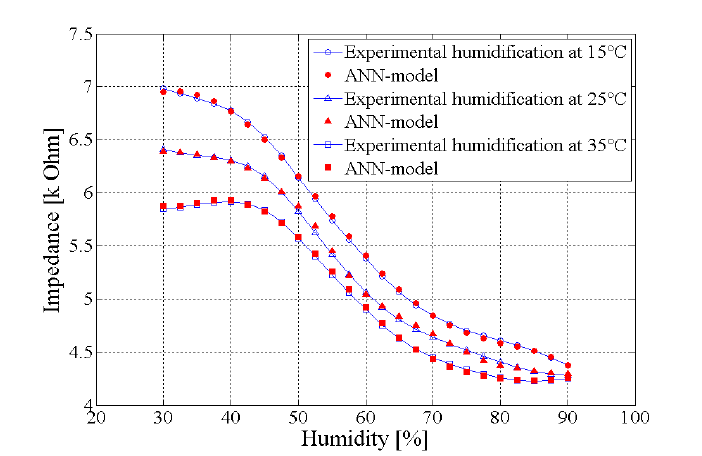
Figure 2. ANN model performance for the sample 1, measured at 1 KHz at fixed temperatures 15, 25 and 35